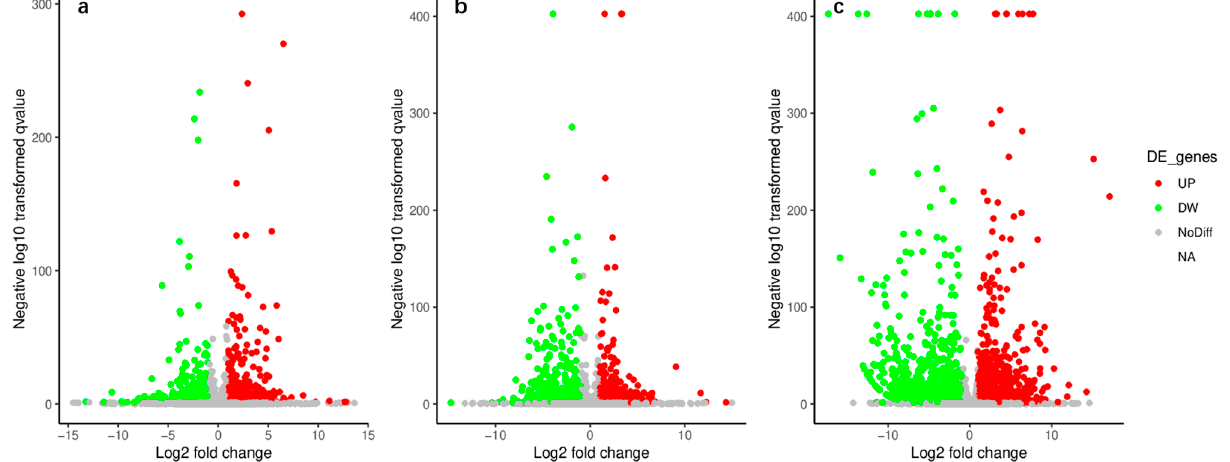
Figure 3. Identification of differentially expressed genes (DEGs) between QC10 vs. GC3 ( a ), QC29 vs. GC3 ( b ), and QC46 vs. GC3 ( c ). Up − , down − regulated genes were represented by red dots and green dots, respectively. The gray dots indicated there was no significant difference of genes.